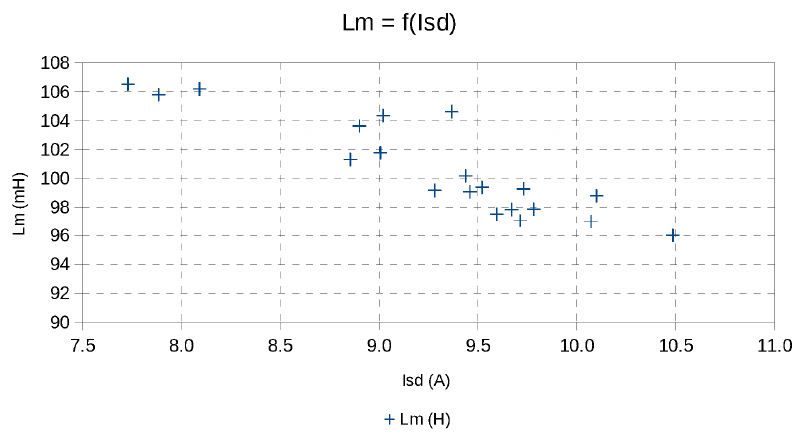
Figure 10. R r as a function of slip frequency f r for different stator frequencies f s .